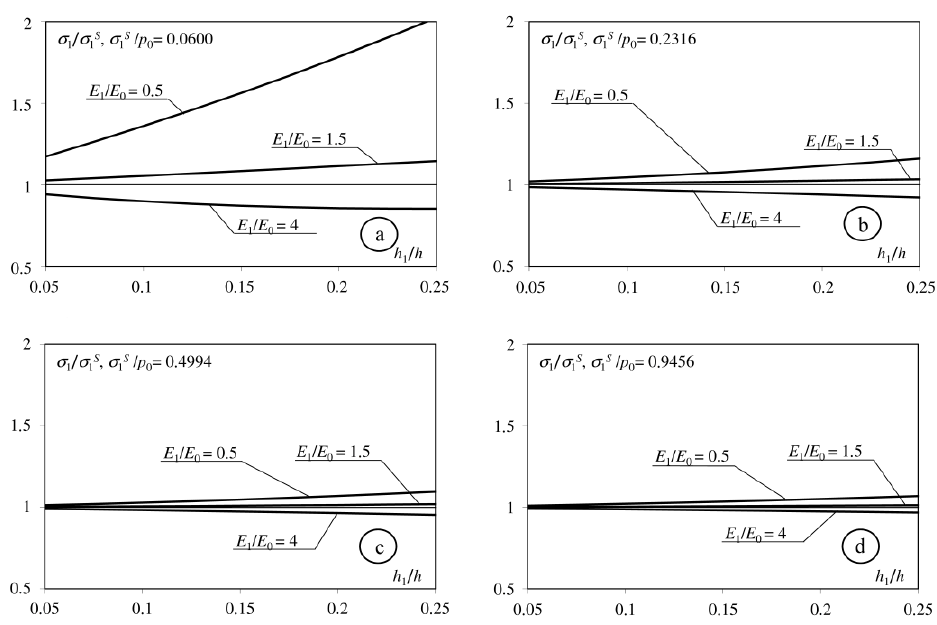
Figure 4. Dependence of the maximum tensile stress on the surface of the considered half-space on the h 1 / h parameters. ( a ): f = 0; ( b ): f = 0.1; ( c ): f = 0.25; ( d ): f = 0.5), h = 0.8; E 2 / E 0 = 2.